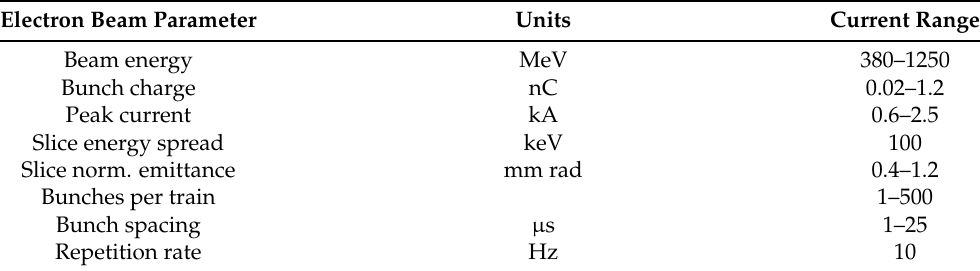
Table 2. FLASH electron beam nominal parameters at the undulator in